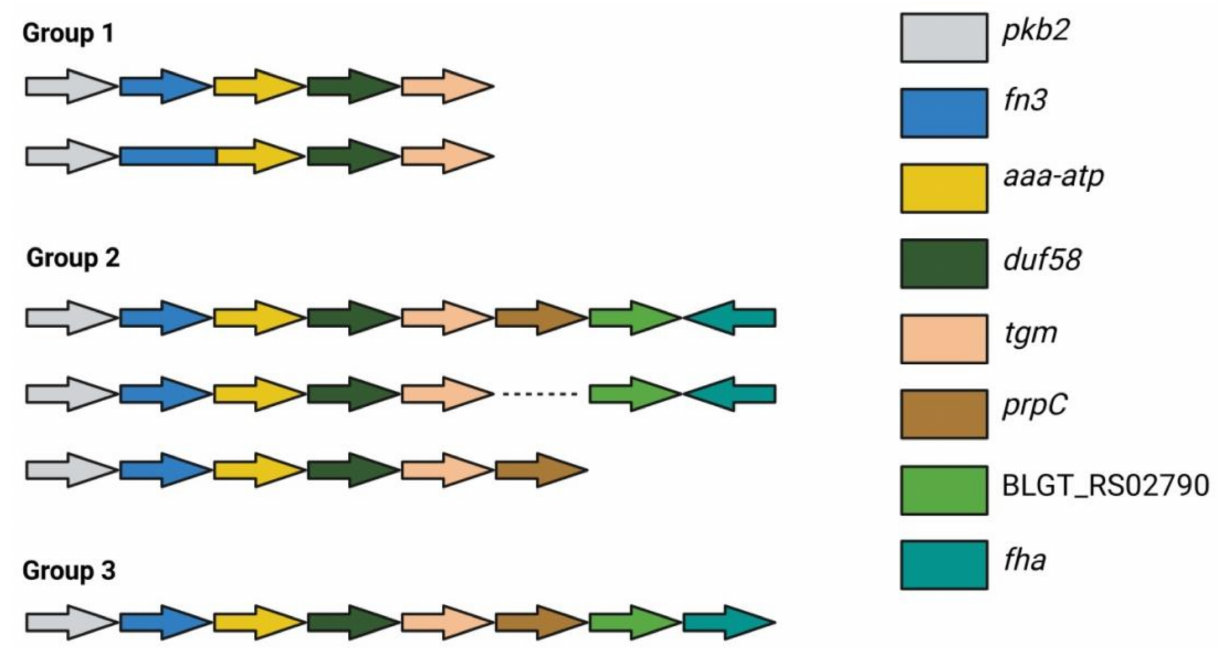
Figure 1. Structure of the PFNA operon across different members of the genus Bifidobacterium . Group 1—the cluster consists of five genes: B. actinocoloniiforme , B. angulatum , B. asteroides , B. biavatii , B. coryneforme , B. indicum , B. lemurum , B. merycicum , B. scardovii , B. thermacidophilum (group 1) and B. breve (there is fusion of genes encoding the fibronectin type III domain-containing protein and AAA-ATPase). Group 2—the cluster contains between six and seven genes: B. adolescentis , B. animalis , B. bohemicum , B. bombi , B. boum , B. catenulatum , B. choerinum , B. commune , B. cuniculi , B. dentium , B. gallicum , B. moukalabense , B. pseudocatenulatum , B. pseudolongum , B. reuteri , B. ruminantium , B. thermophilum and B. kashiwanohense (the gene prpC is absent), B. stellenboschense (the gene BLGT_RS02790 is absent). Group 3—the cluster contains eight genes: B. aesculapii , B. bifidum , B. longum , B. saguini . The arrows indicate the direction of transcription of the genes [54]. Adapted from